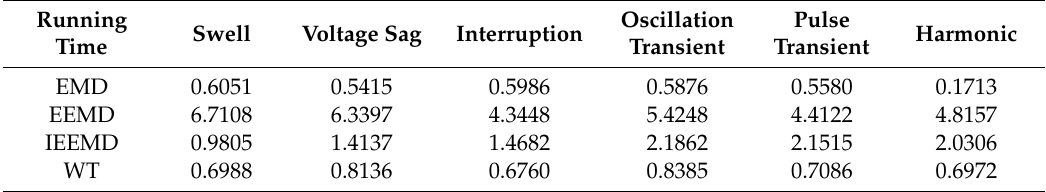
Table 6. The running time of the detection